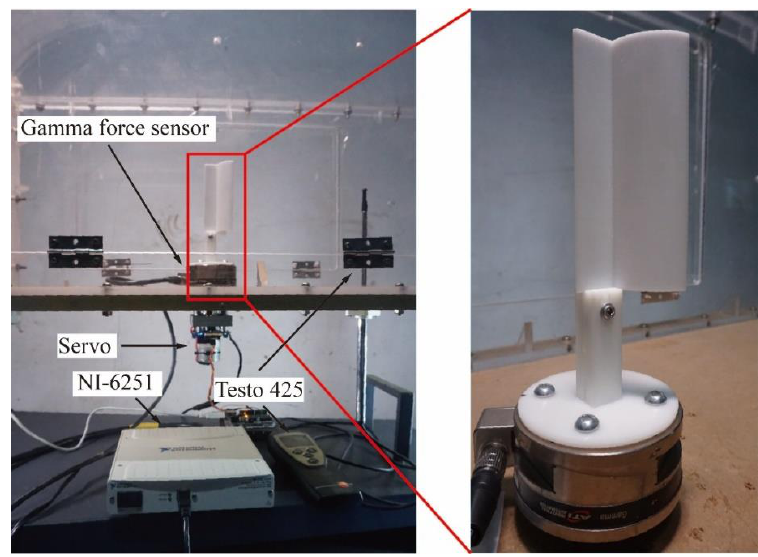
Figure 5. Configuration of force measurement tests.